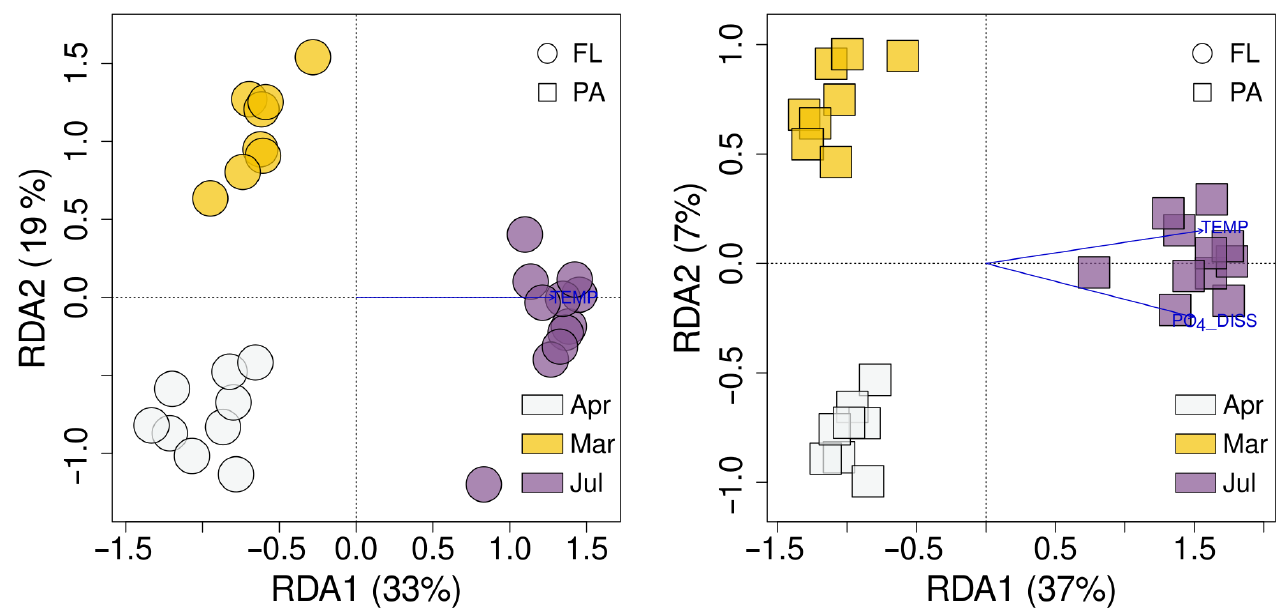
Figure 13. Constrained ordination of FL and PA communities’ profiles by redundancy analysis. Blue vectors are environmental factors incorporated into the tb-RDA model by forward selection.